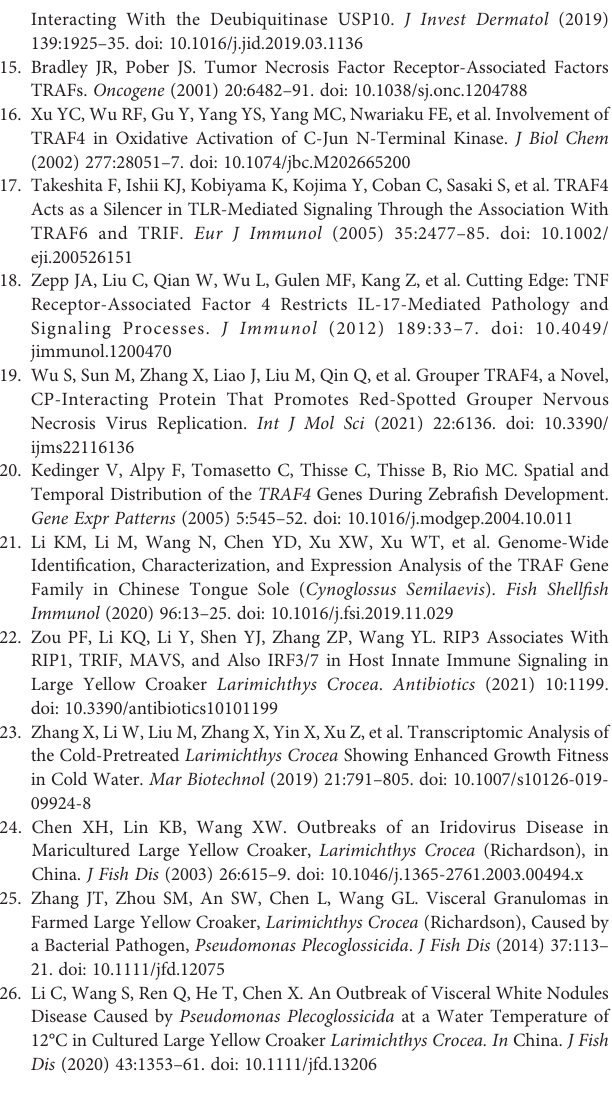
Supplementary Figure 1 | Multiple alignment of the protein sequence of Lc - TRAF4 with other vertebrate TRAF4. Black shaded sequences indicate locations where all sequences share the same amino acid residues, whereas gray shading and light gray shading represent conserved and semi-conserved amino acid substitutions, respectively. The conservation RING fi nger domain, zinc fi nger domain, and MATH domain are represented with black arrows,